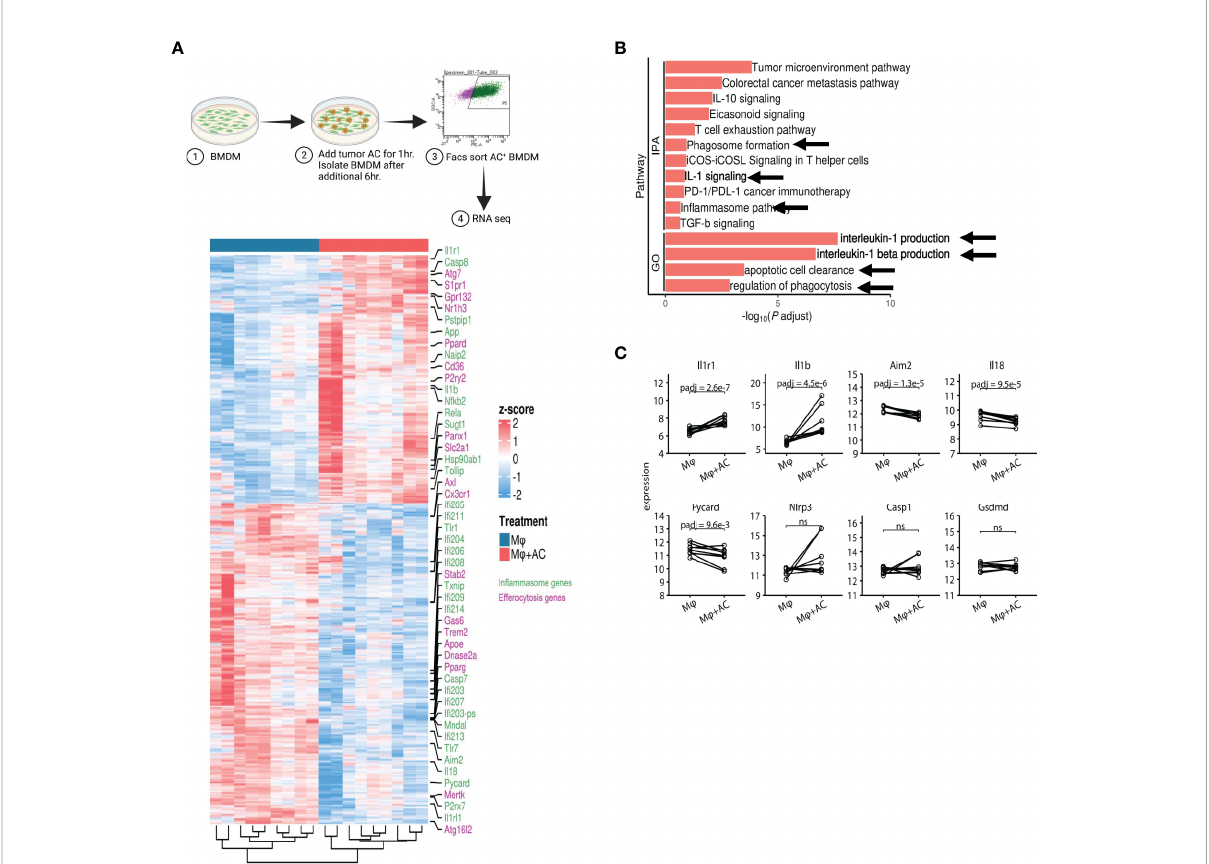
FIGURE 7 Efferocytosis in macrophages upregulates in fl ammasome gene expression. (A) Experimental work fl ow and heatmap for induction of efferocytosis in mouse bone marrow derived macrophages and subsequent RNA-seq (n=5). BMDM were incubated with PKH26 labeled AC for 1hr. Non-engulfed AC were washed with 1X PBS and after an additional 6hr, PKH26 + BMDM were sorted and processed for RNA seq. Heatmap showing differential gene expression pro fi les between macrophages pre and post induction of efferocytosis as measured by bulk RNA-seq. (B) IPA and GO analyses show increased expression of IL-1 signaling pathways post efferocytosis. (C) Graphical representation of selected in fl ammasome genes indicate enrichment of NLRP3/IL-1 pathway post efferocytosis. ns, not signi fi